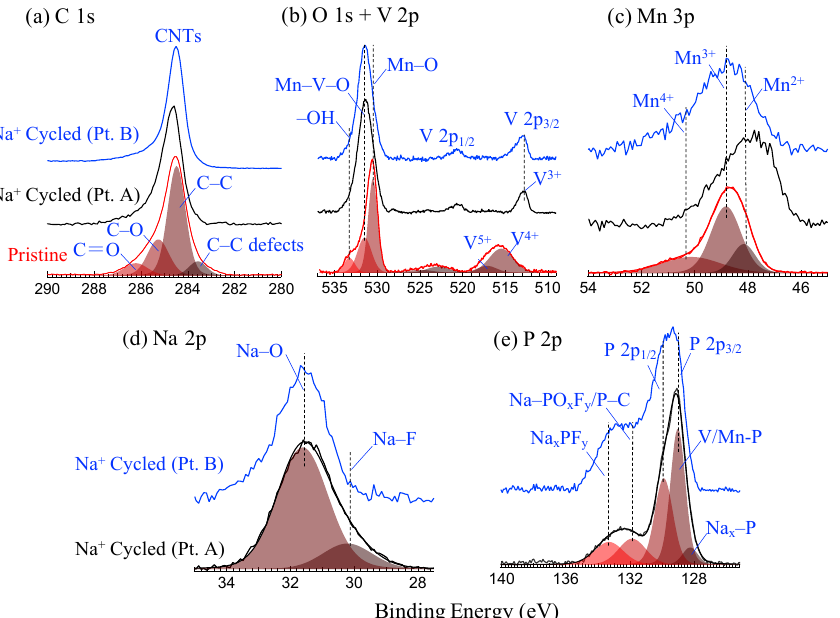
Figure 5. X-ray photoelectron spectroscopy (XPS) core level spectra of C 1s ( a ), O 1s + V 2p ( b ), Mn 3p ( c ), Na 2p ( d ) and P 2p ( e ). Point A (Pt. A) and Point B spectra were acquired on the positions as shown on SPEM map in Figure 4j on Na + cycled sample. XPS core-level spectra intensity are shown as